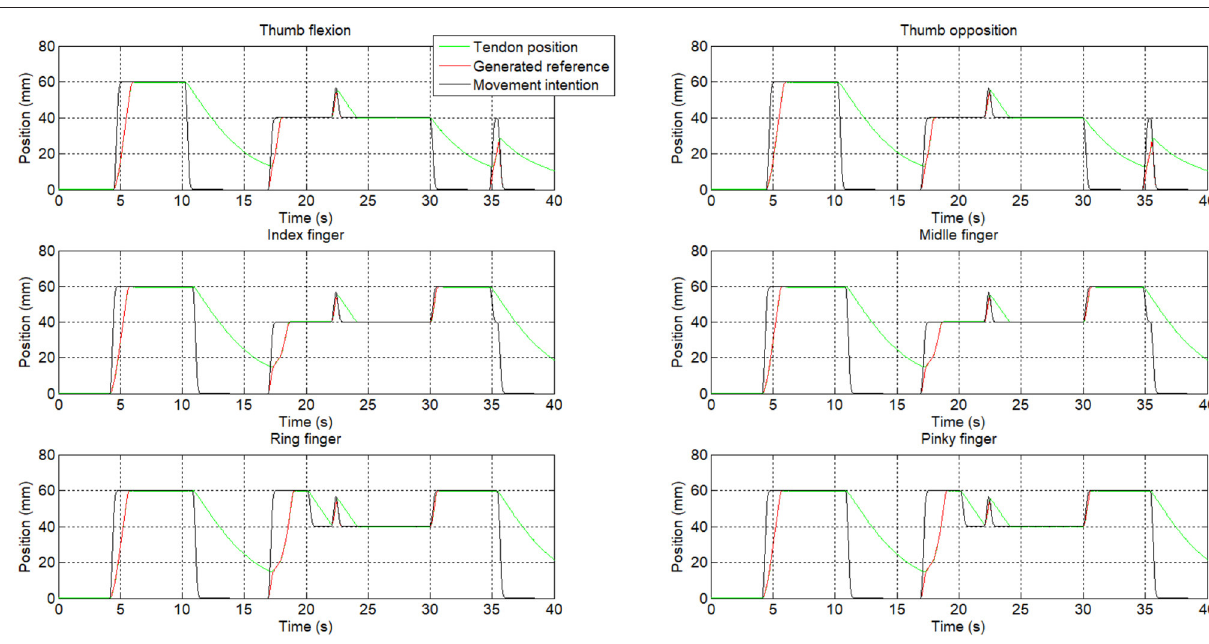
armband was used and the sEMG signal was split into 260 ms segments, observing that the classifier accuracy grew with the training repetition. In another work, the accuracy of the classifier was between 81.9 and 90.1% (Wei et al., 2019), the better score was obtained with the multi-view convolutional neural network using both Myo armbands (16 channels)